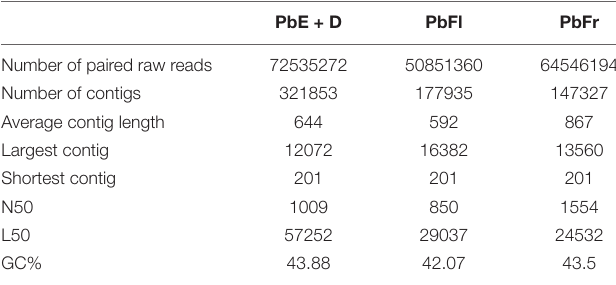
TABLE 1 | Statistics of the PbE + D, PbFl, and PbFr transcriptomes. PbE +